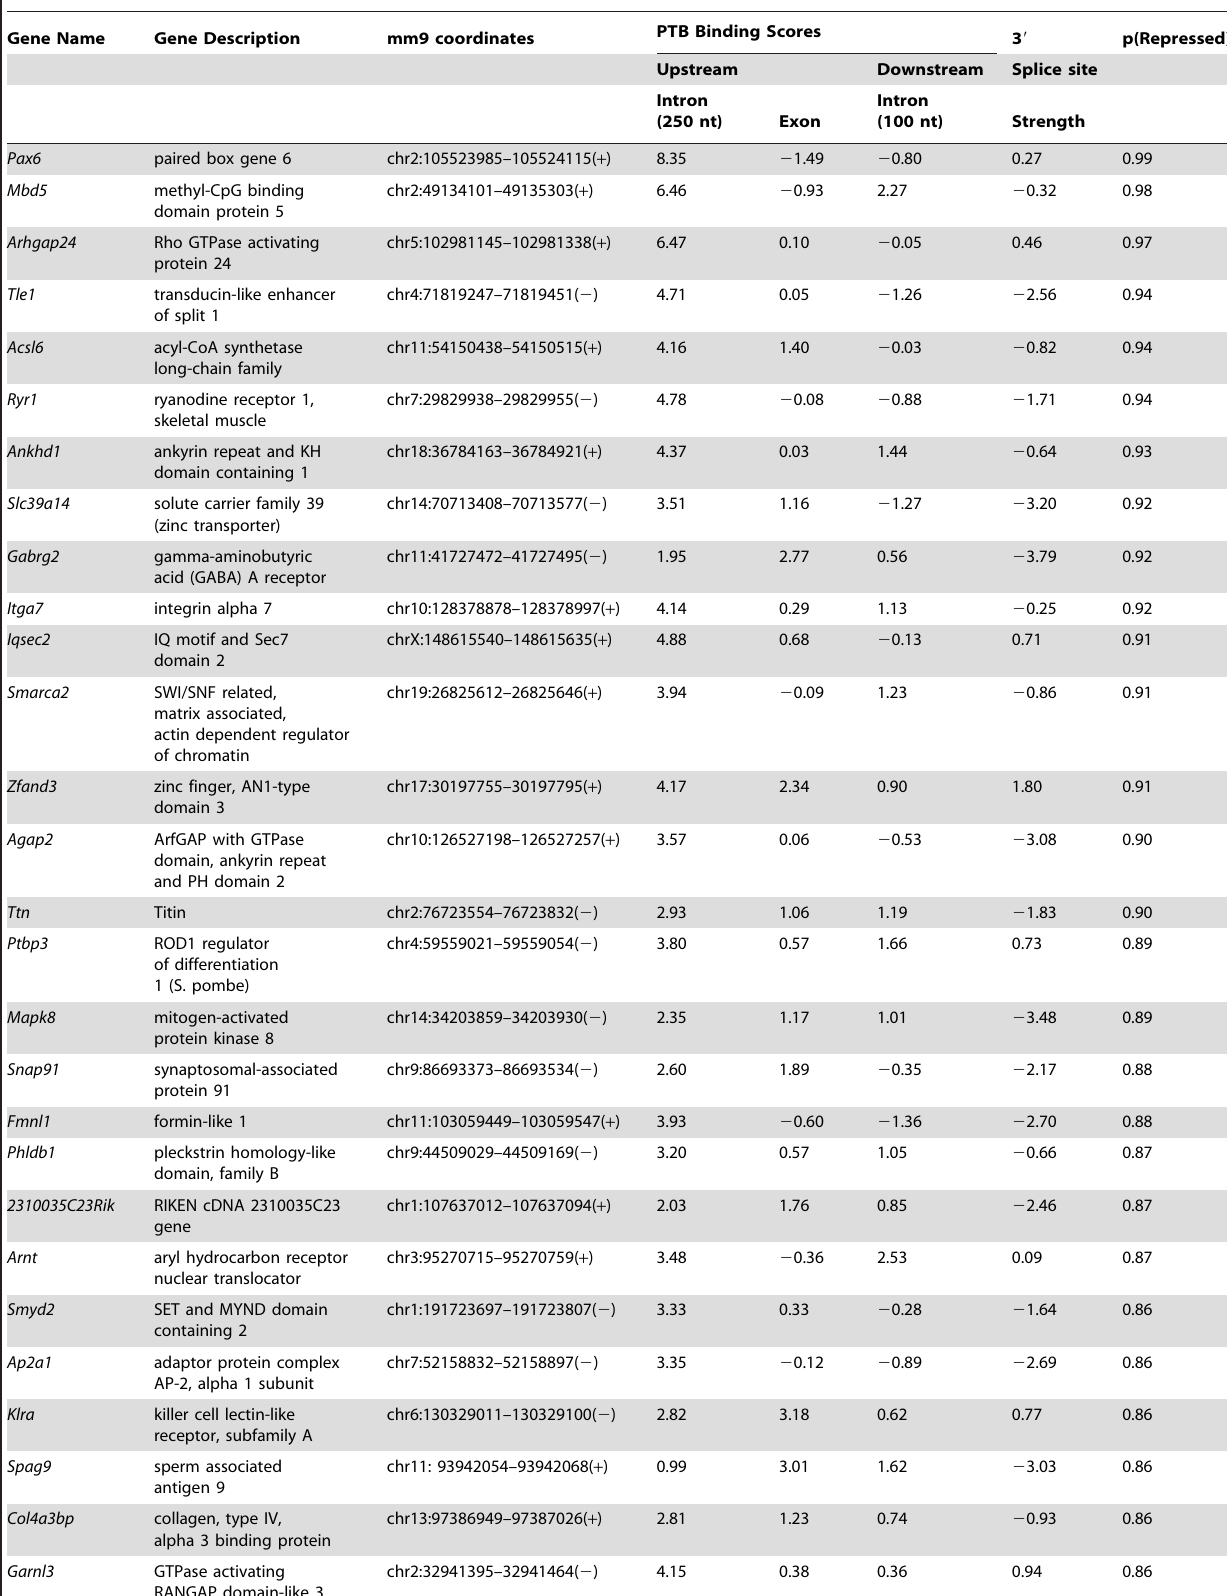
Table 1. PTBP1 repressed exons identified by the splicing